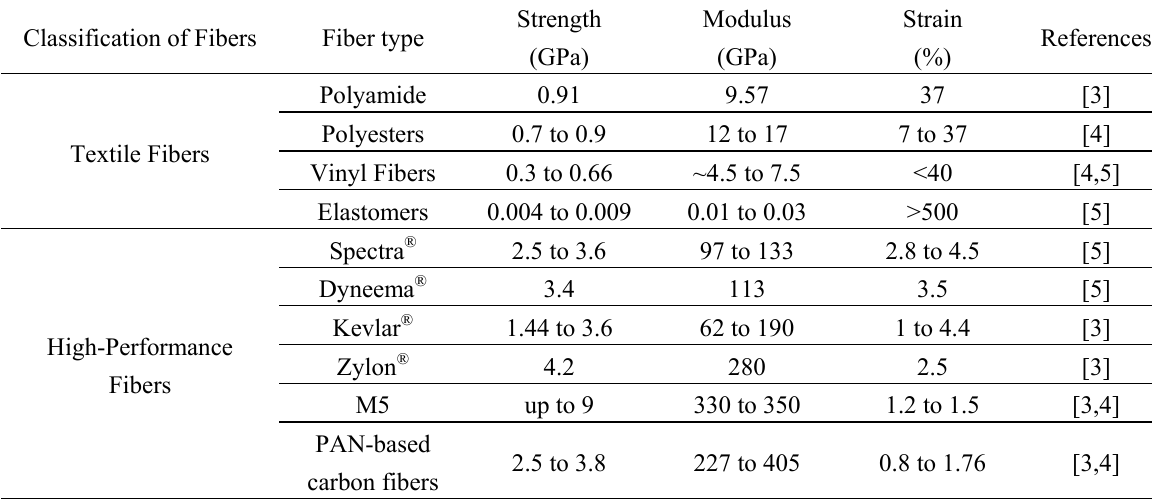
Table 1. Typical mechanical properties’ values for commercially available polymer fibers used for textile and high-performance